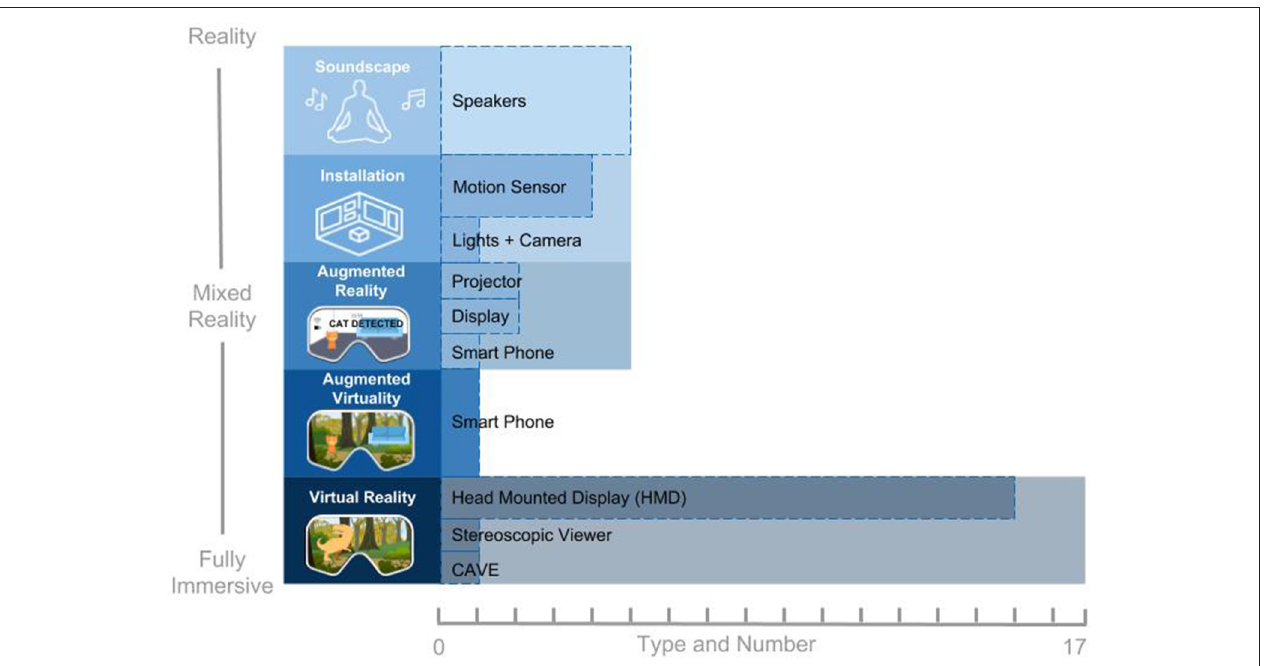
FIGURE 3 | The type and number of immersive, interactive experiences for positive functioning (x-axis). Types of immersive, interactive experiences are categorized on a virtuality continuum (y-axis) that increases in immersive properties from soundscape (least immersed) to virtual reality (fully immersed). Each type is broken down into the kind and number of technology used, and this is represented as the dotted bars within the larger bars representing the total number of